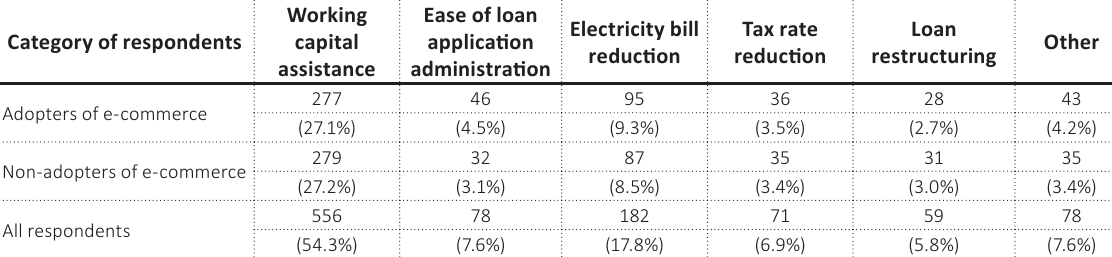
Table 7. Types of assistance required due to the COVID-19